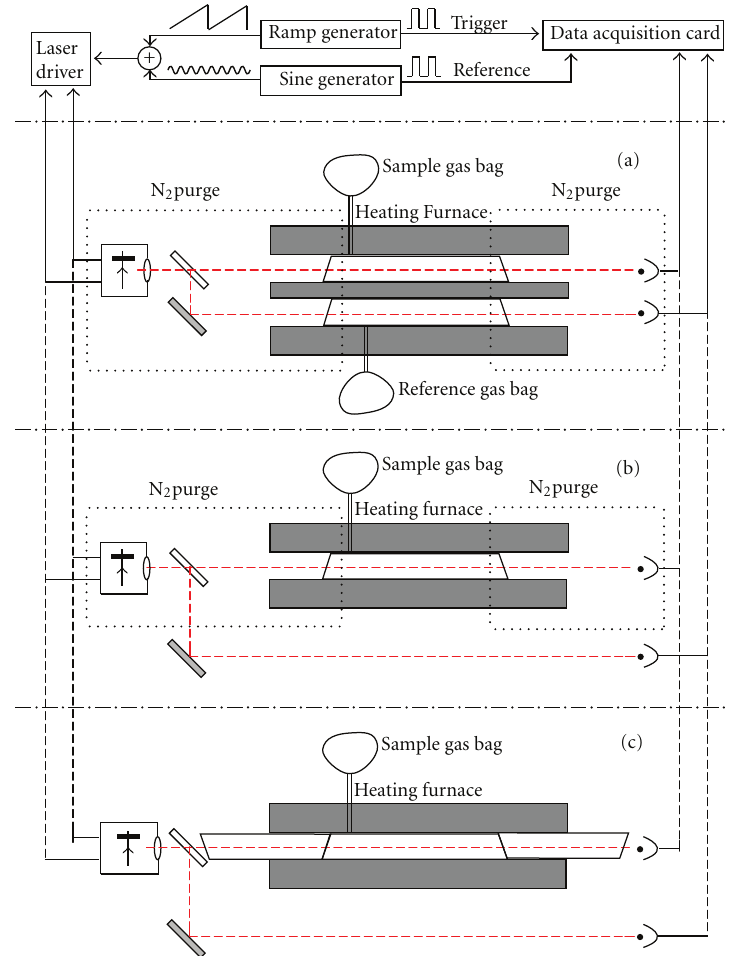
F 3: Experimental setup for oxygen measurements by MDL-COSPEC technique, with the electronic section (above) and the measurement section (below) divided in three different schemes to simulate coal-combustion exhaust gas monitoring at the tail of �ue. (a) Both sample and reference cells were purged with nitrogen gas and heated to the same temperature conditions; (b) the sample cell was purged with nitrogen gas, and oxygen in open air at room temperature was used as a reference gas; (c) a three-zone sample gas cell was employed with both end sections sealed with nitrogen gas, and oxygen in open air at room temperature was used as a reference